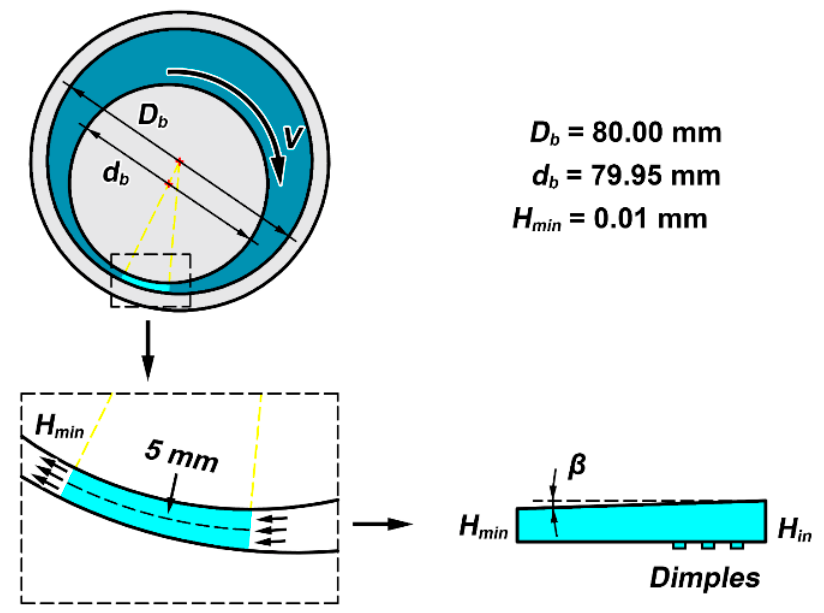
Figure 1. Schematic of the journal bearing contact under hydrodynamic lubrication (5 mm indicates the length of the picked flow area).